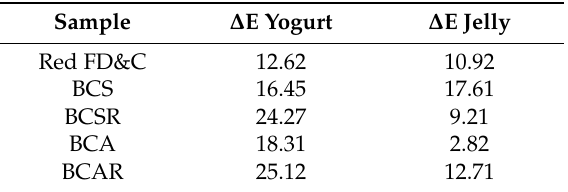
Table 2. Color comparison between food models (yogurt and jelly) using black carrot extracts after 25 days in